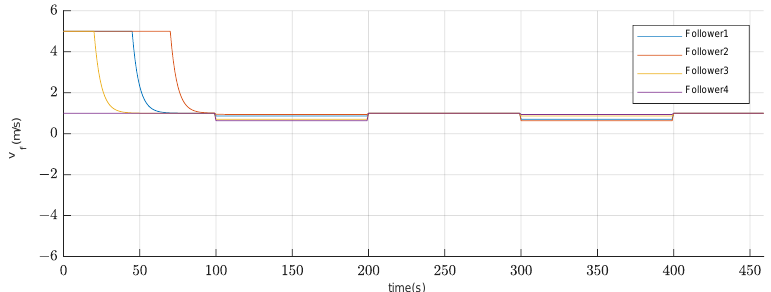
Figure 17. The variation curves of v f for each follower during the movement.